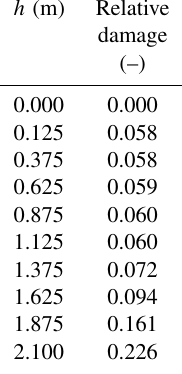
Table A1. SEMP model: empirical curve obtained from the bin- ning procedure in terms of water depth ( h ) and relative damage to buildings (see Sect. 4.2.1 for the procedure adopted to develop the